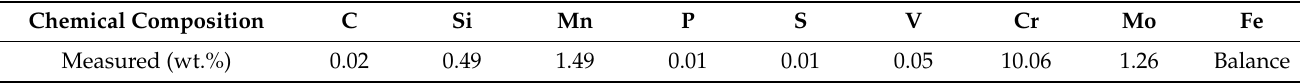
Figure 1. Illustration of SNC processing of rusted rebar sample ( a ) and optical images of the rebar sample with different surface conditions ( b ). Table 1. Chemical compositions of Cr-alloyed